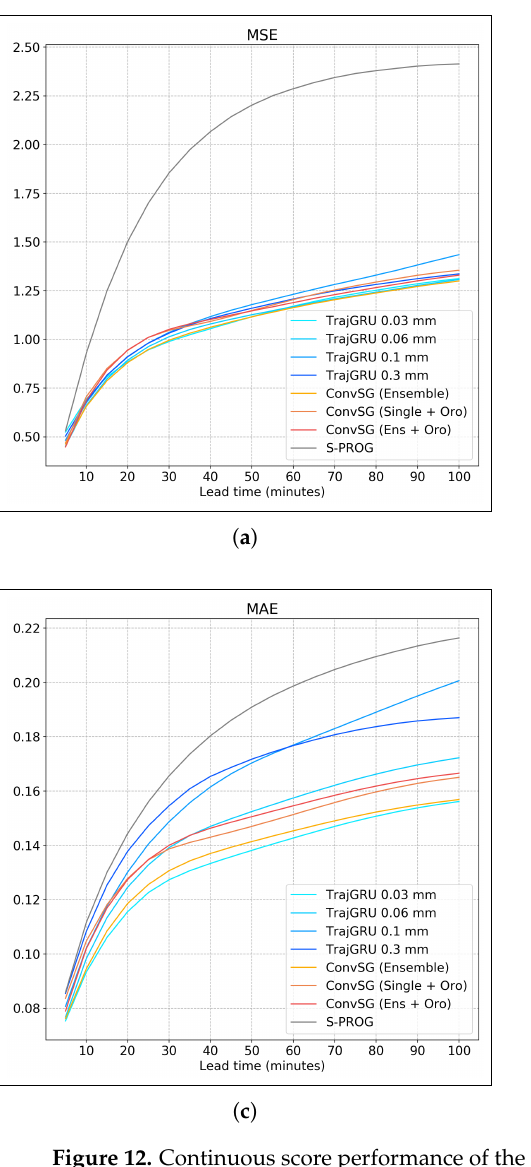
Figure 12. Continuous score performance of the model: ( a ) mean squared error; ( b ) normalized mean square error; ( c ) mean absolute error; and ( d ) conditional bias (closer to 1 is